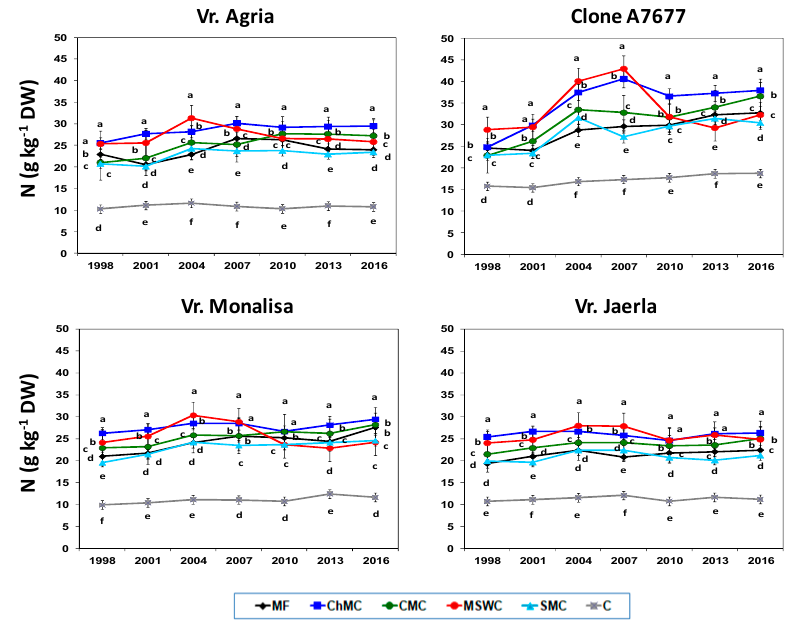
Figure 4. Evolution of the nitrogen content (grams per kilogram of dry matter (g kg − 1 DW DW)) in potato tubers of the Agria, Monalisa, Jaerla and clone A7677 varieties (1998–2016) versus the application of compost from different organic amendments. The means with different lowercase letters within each season indicate significant differences between the treatments ( p < 0.001). Bars stands for standard deviations. MF: mineral fertilizer; ChMC: chicken manure compost; CMC: cow manure compost; MSWC: municipal solid waste compost; SMC: sheep manure compost; C: control.